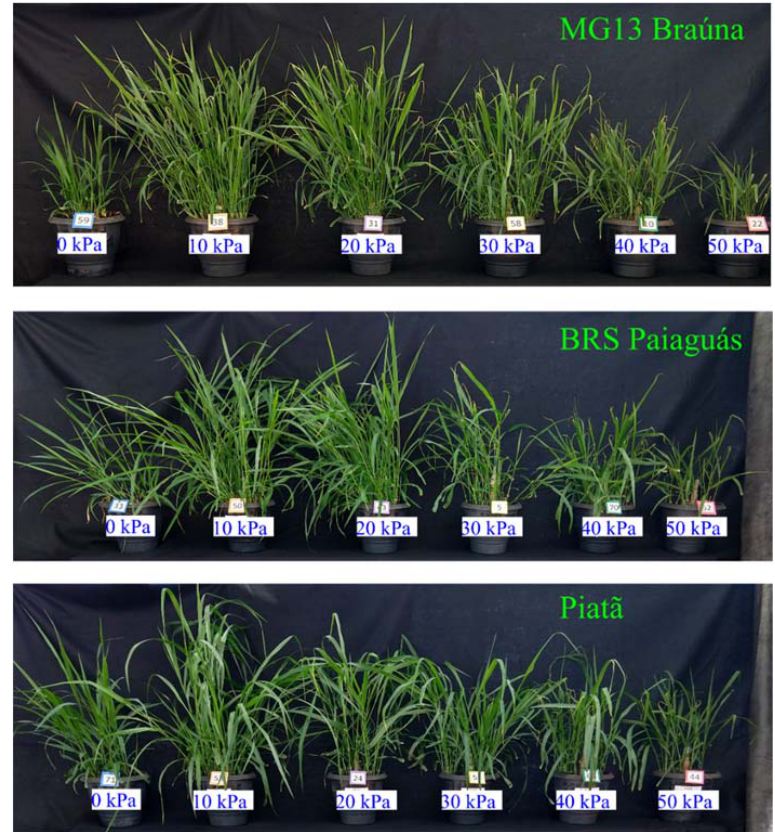
Figure 5. Cultivars of Brachiaria brizantha , MG13 Bra ú na, BRS Paiagu á s, and Piat ã at soil water pressure head | h | 0, 10, 20, 30, 40, and 50 kPa on the 30th day after the first cut (70